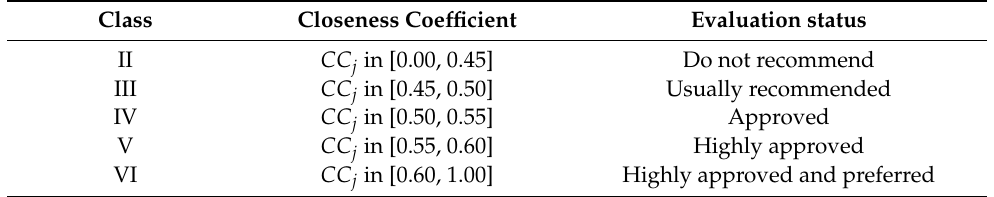
Table 7. Class types for CC j .